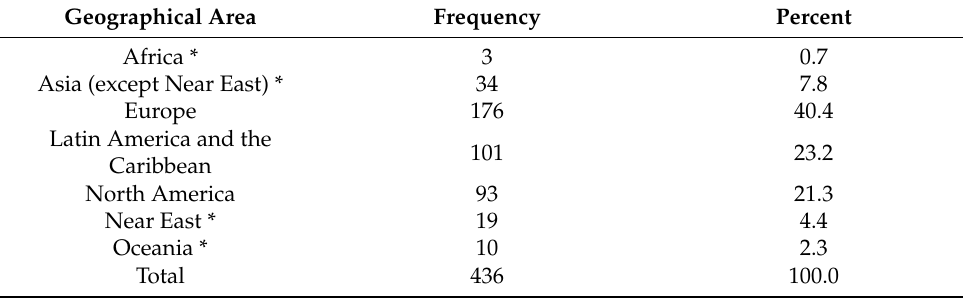
Table 1. Distribution of surveyed dentists by geographical area. Geographical